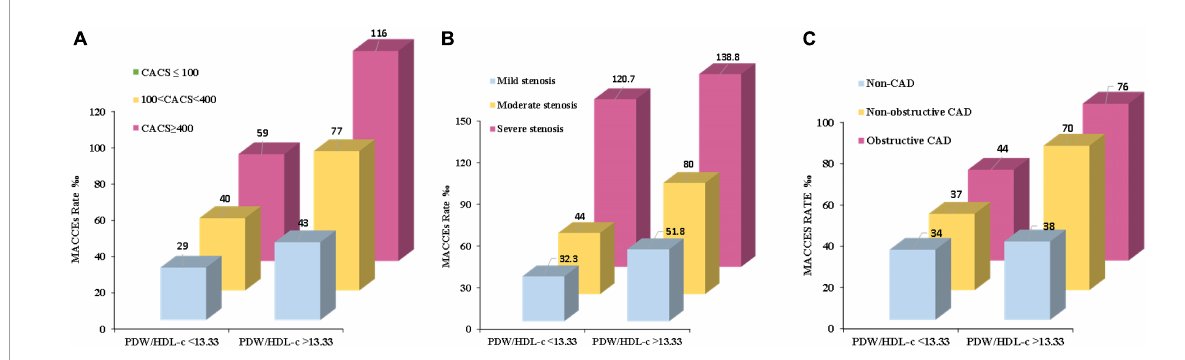
FIGURE3 The MACCE rate in high and low PDW/HDL-C ratio groups among different severities of CHD. (A) Patients were stratified by CTA in the severity of coronary artery calcification (CACS ≤ 100, CACS 100-400 and CACS > 400). (B) Patients were stratified by CTA in the extent of coronary stenosis (mild stenosis < 50% luminal stenosis, moderate stenosis 50% – 75% luminal stenosis, and severe stenosis > 75% luminal stenosis). (C) Patients were stratified by CTA in the obstructive disease classification (no CAD: absence of any plaque, non-obstructive CAD: all coronary arteries < 50% luminal stenosis, and obstructive CAD: at least one artery > 50% luminal stenosis). Multivariate analysis of variance was used to compare the incidence of MACCEs in high and low ratio groups at different stratification.